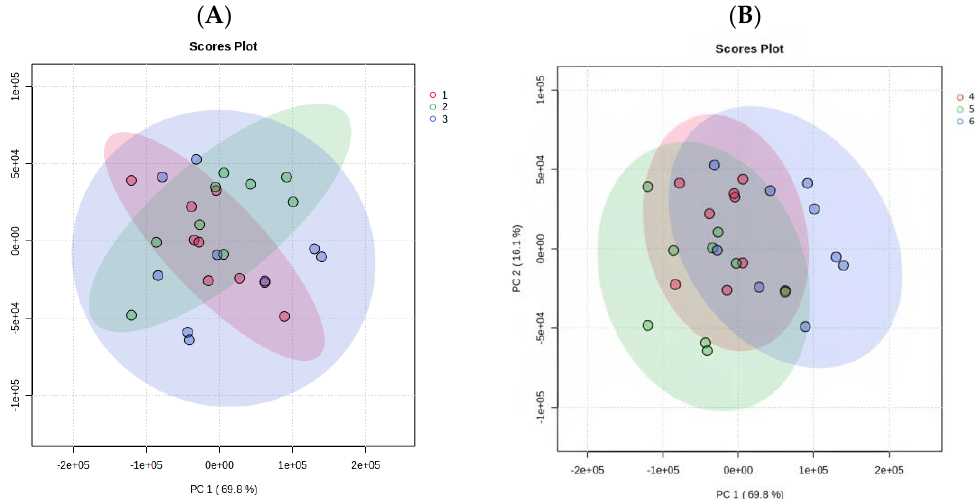
Figure 2. PCA score graph of the metabolomic analysis of lemon peel cultivated under nine different treatments (three rootstocks × three substrates), highlighting ( A ) differences based on the substrate employed and ( B ) differences based on the rootstock, where 1 to 3 corresponds to the rootstock type as (1) Citrus macrophylla ; (2) Citrus aurantium ; and (3) Citrus aurantium / Citrus sinensis ; and 4 to 6 is related to the culture media: (4) 75% peat + 25% port sediment; (5) 50% peat + 50% port sediment; and (6) 25% peat + 75% port sediment.